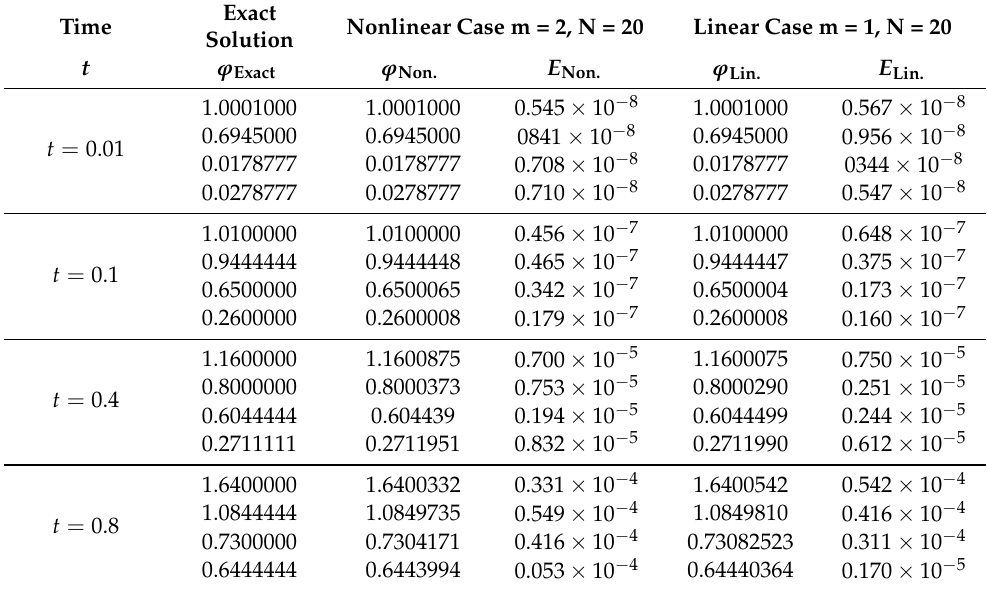
Table 2. Describes the nonlinear and linear cases for MIE (44), with the Carleman kernel, time and β = 0.01.